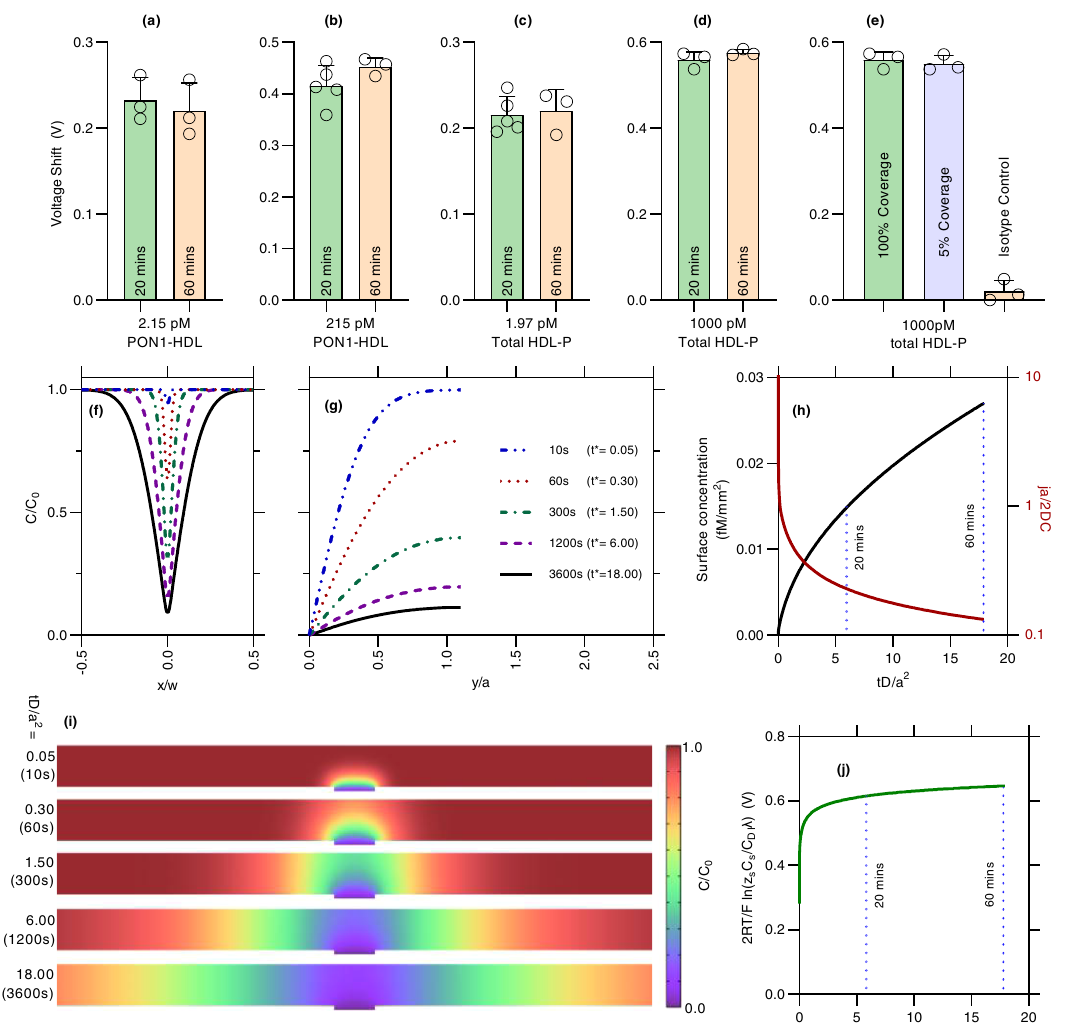
Fig.4|Variationofsignalwithtimeandeffectofmass-transferlimitationfora small sensor. a – d shows the signal at different times for 2.15pM PON1-HDL, 215pM PON1-HDL, 1.97pM HDL-P, and 1000pM HDL-P showing almost identical signalsbetween20and60min. e Effectofantibodysurfacecoverageontheoverall signal with 100%, 5% and 0% coverage. Similar signal between 100% and 5% sug- gests we are in mass-transfer limited regime. f , g shows the concentration at the channel center along the channel and directly above the membrane (membrane locatedatorigin),andhowtheconcentrationgradientdecreasesovertime.Shared fi gure legend for both f and g shown in the latter. h Surface concentration of